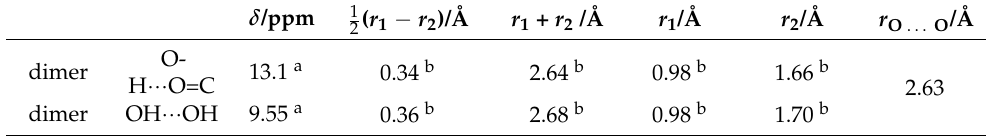
Table 4. Estimates of hydrogen bond geometries of the TMRA dimer from the OH chemical